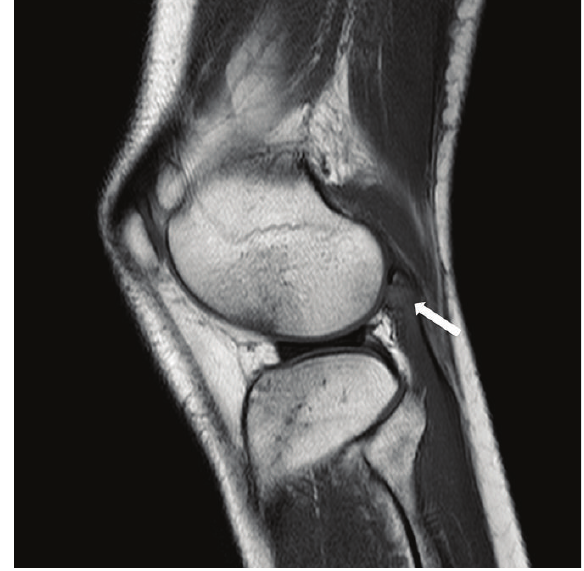
Figure 3: T1-weighted fast spin-echo MRI showed bone contusions in the anterior femoral and tibial regions at the lateral tibiofemoral compartment, related to hyperextension and valgus mechanisms of